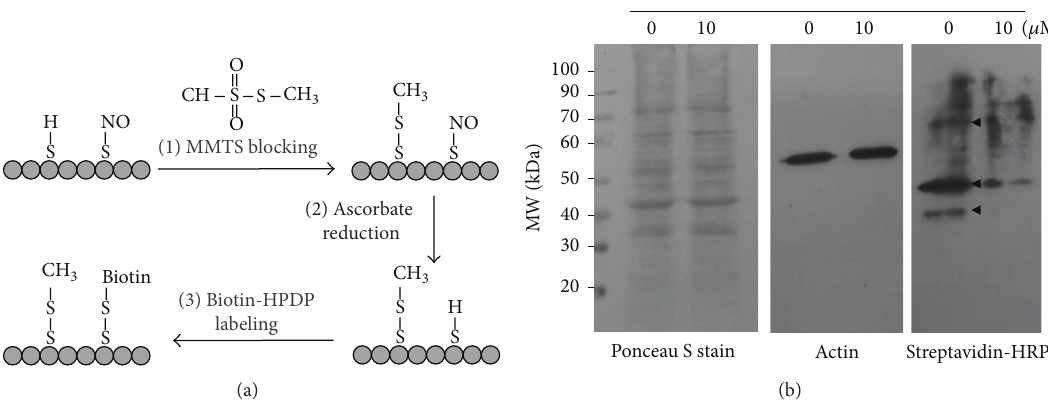
Figure 1: The arsenic decreases protein S-nitrosylation in primary keratinocytes. (a) The scheme of biotin switch showed that the NO on the cysteine residue was replaced by biotin. (b) After biotin switch, 40 𝜇 g of biotinylated lysates treated with 10 𝜇 M of arsenic for 1h was separated by SDS-PAGE. The blotted membrane was prestained by Ponceau S and western blotted with actin (1:3000). Both two were applied as loading control. Streptavidin-HRP (1:3000) was applied to detect biotinylated proteins. The decreased S-nitrosylated proteins after arsenic treatment were indicated as